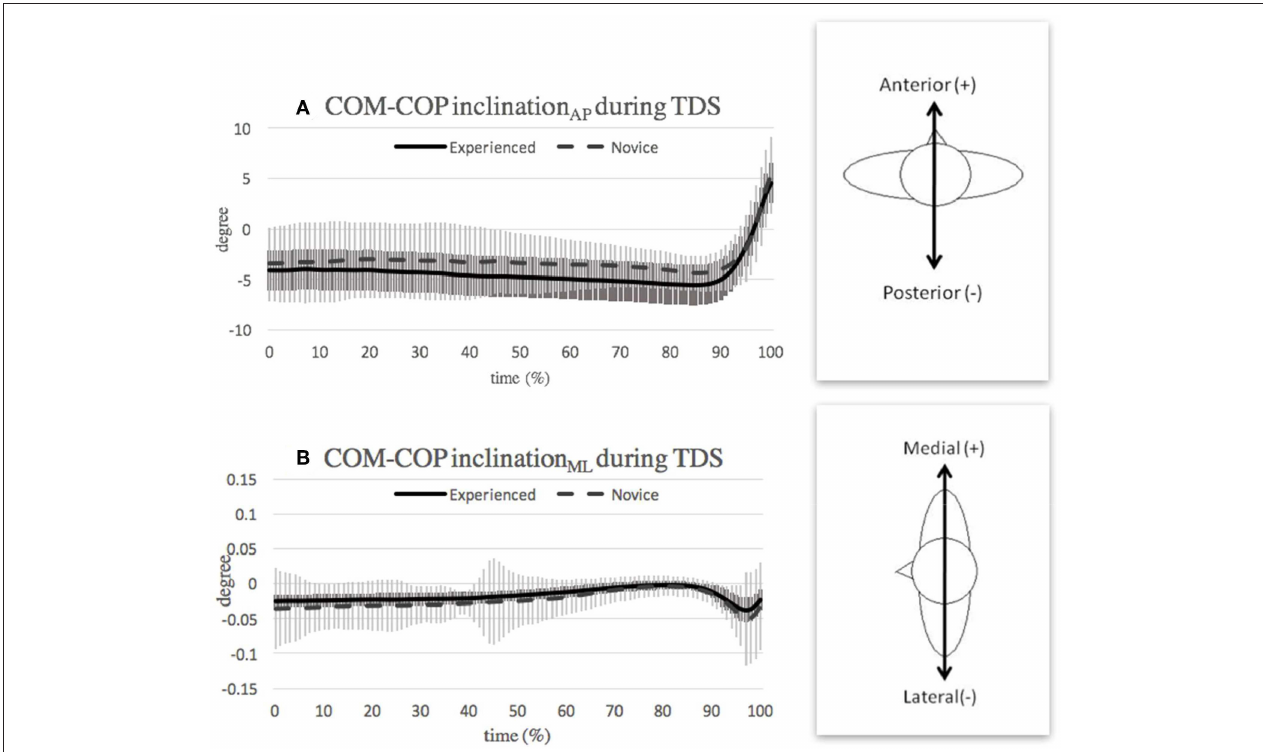
FIGURE 4 | Mean and SD of COM-COP inclination angle in (A) anterior-posterior direction and (B) medial-lateral direction during turning with double-leg support (TDS) phase. Note that the curves show the average value obtained over the three highest-scoring trials of each individual in the respective